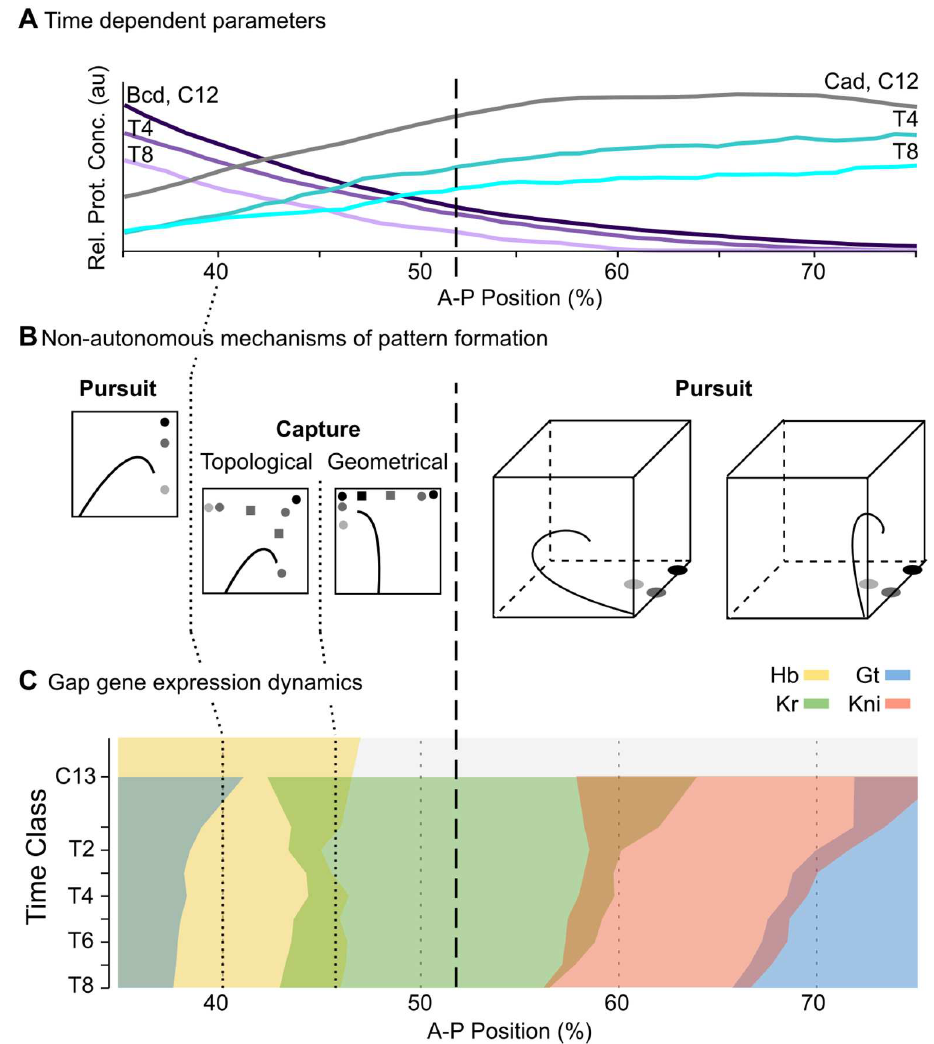
Fig 8. Summary of non-autonomous mechanisms for gap gene pattern formation in D. melanogaster . (A) Non-autonomous gap gene circuits implementrealistic, time-dependent dynamicsof maternal morphogen gradients(Bcd in purple, Cad in cyan). Y-axis shows relative protein concentration (in arbitrary units, au); X- axis shows %A–P position,where 0% is the anterior pole. (B) Different non-autonomous mechanisms of pattern formation are active at different positionsalong the A–P axis of the embryo. Stylized projectionsof phasespace are shown. See S1B Fig and [43] for nomenclature. (C) Gap gene expressiondynamics differ betweenthe anterior and the posterior regions of the embryo. While domain boundariesin the anterior are stationary, boundaries in the posterior shift towards the anterior over time. Time-spaceplot as in Fig 1A: note that time flows downward along the y-axis (cycle C13 and time classes T1–8 as definedin Models and Methods). The dashed vertical line spanningall panelsindicates a bifurcation event at 52% A–P position, which separates the multi-stable from the